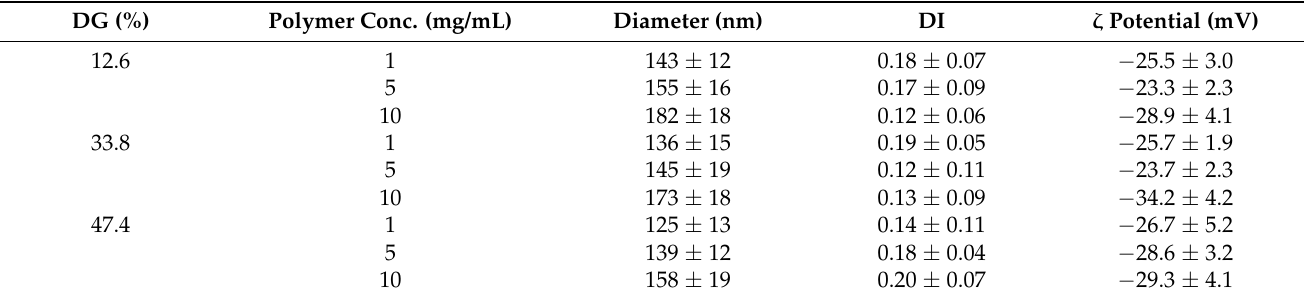
Table 4. BMO-PUL nanoformulation characteristics at various conc. and DG ( n = 3; ± SD). DG (%)